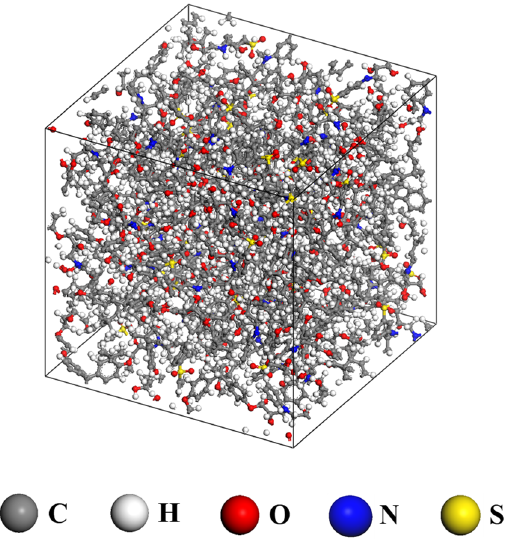
Figure 2. Example of the equilibrated structures of the epoxy resin system.